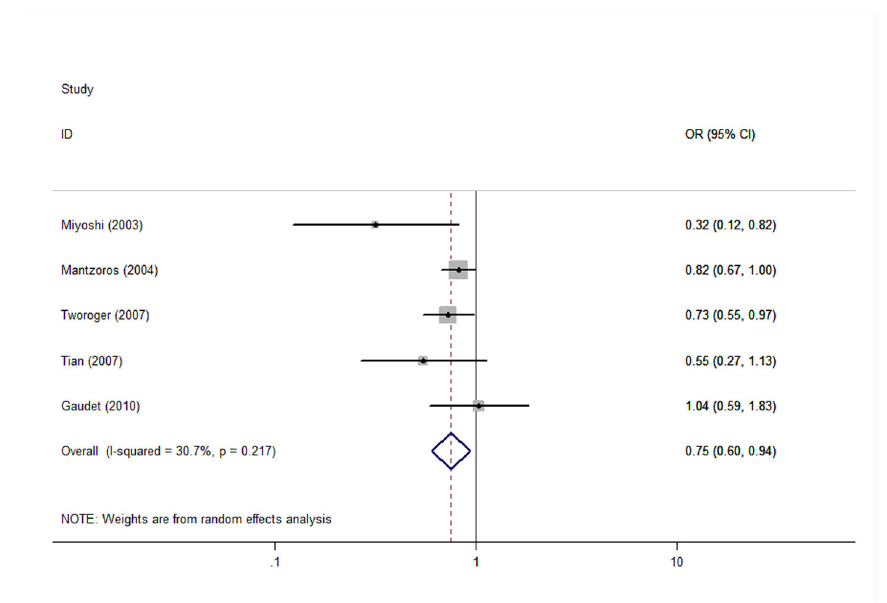
Figure 3. The effect of adiponectin on postmenopausal breast cancer.